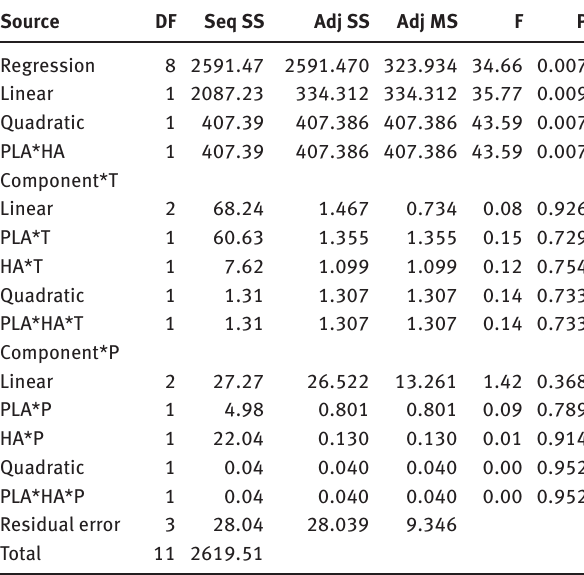
Table 12: Variance analysis of cell viability